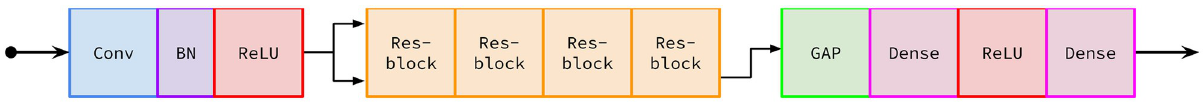
Fig 5. The full architecture used in PCLR pre-training. The projection head, beginning at the first Dense (fully connected) layer, is applied to the output of the ECG